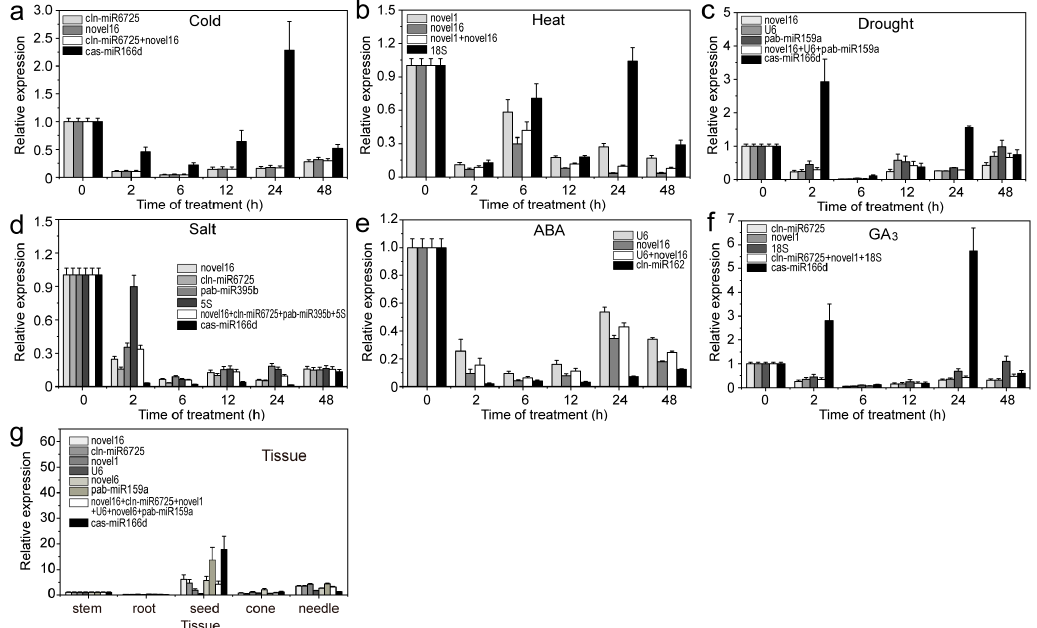
Figure 8. Relative expression levels of aly-miR164c-5p under different experimental conditions. Results for ( a ) 4 ◦ C cold stress; ( b ) 40 ◦ C heat stress; ( c ) drought stress simulated by 15% PEG-6000 treatment; ( d ) salt stress stimulated by 200 mM NaCl treatment; ( e ) 200 μ M ABA treatment; ( f ) 200 μ M GA 3 treatment; ( g ) different tissues (roots, stems, tender needles, cones and seeds). Error bars represent standard deviations (SD) (n = 3).